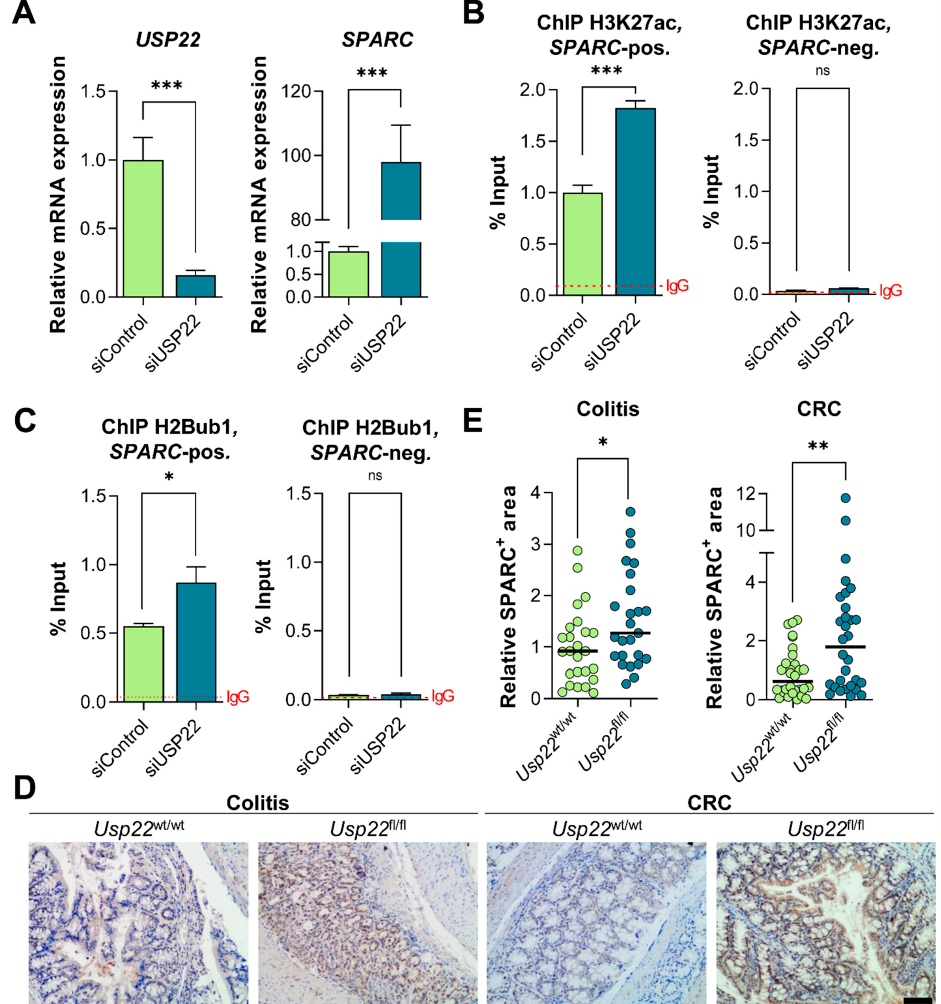
Figure 6. USP22 epigenetically suppresses SPARC expression by affecting the occupancy of acetylated lysine 27 of histone H3 (H3K27ac) and monoubiquitinated histone H2B (H2Bub1). ( A ) The siRNA-mediated reduction of USP22 levels as well as the induction of SPARC expression in HCT116